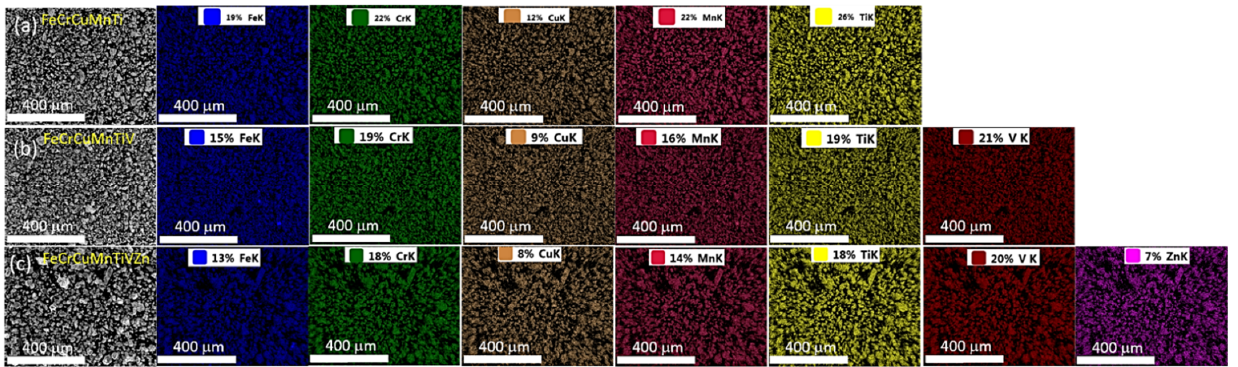
Figure 4. HRSEM BSE images over the powder surface morphology of three developed high entropy alloy powders: ( a , b ) FeCrCuMnTi; ( c , d ) FeCrCuMnTiV; and ( e , f ) FeCrCuMnTiVZn.